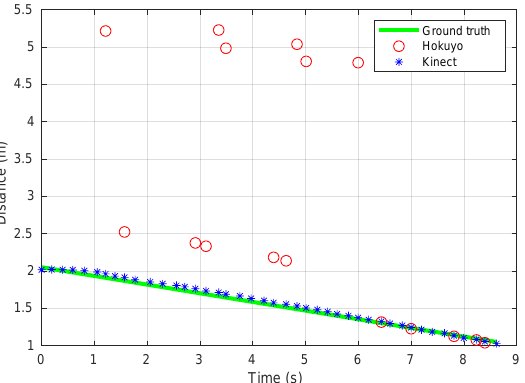
Figure 8. Range measurements obtained by the Hokuyo and the Kinect sensors during the experiment in Figure 7, along with the ground-truth